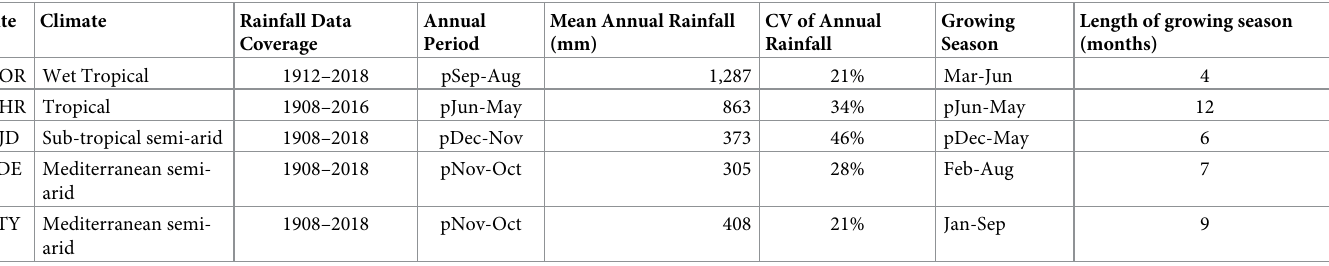
CV is the coefficient of variation. Growing season is the period of consecutive months that showed the highest Pearson correlation between rainfall and tree growth (ring-width index). Lower case ‘p’ indicates the month is in the calendar year prior to the main growing